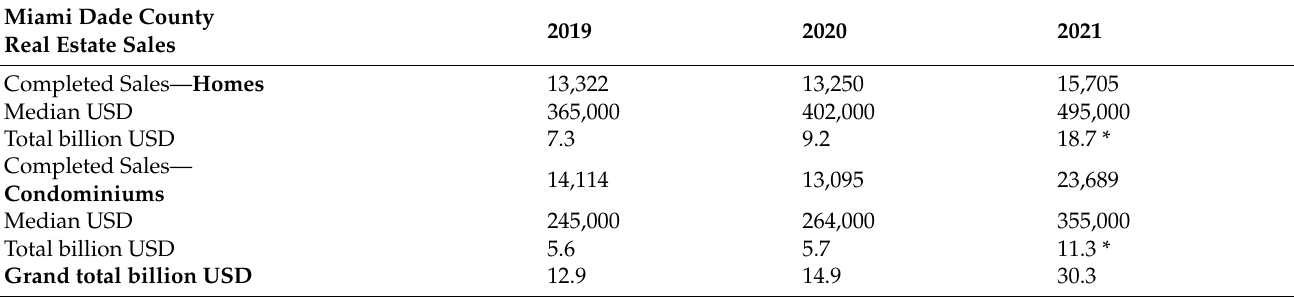
Table 1. Completed real estate transactions, Miami-Dade County,